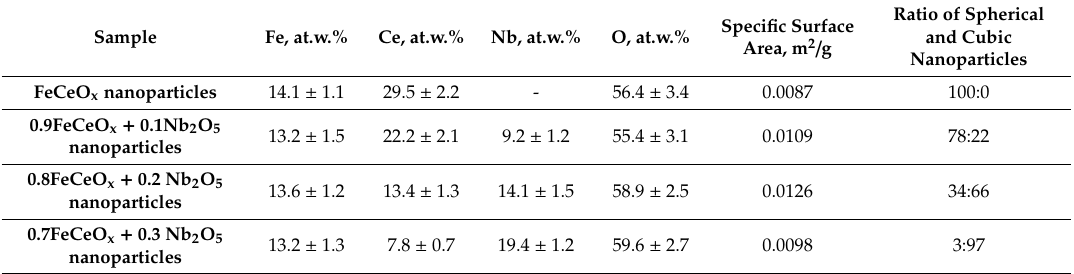
Table 1. Elemental analysis data, specific surface area, and particle type ratio. Sample